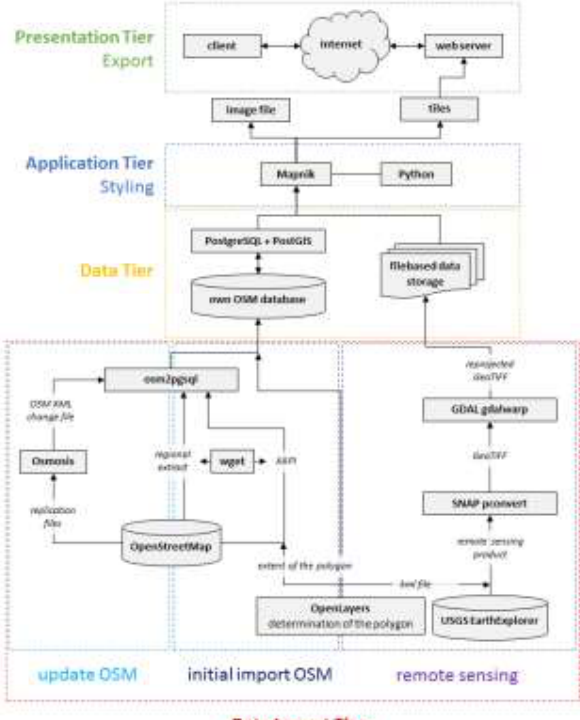
Figure 1. System architecture and